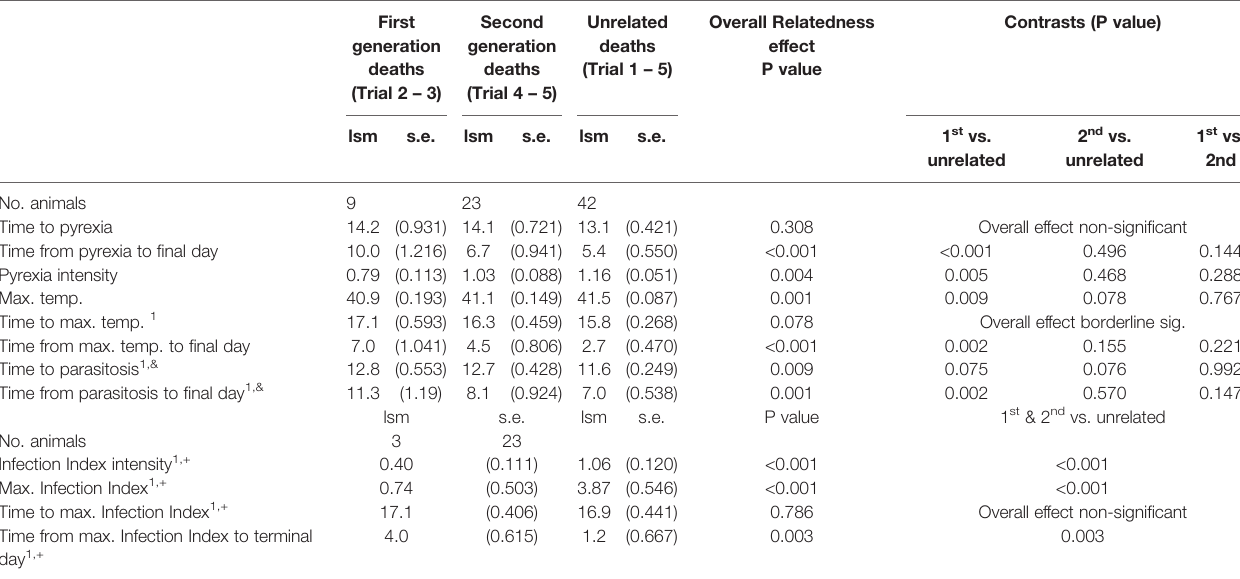
TABLE 4 | Survival, parasitosis and pyrexic data from the susceptible progeny and the susceptible unrelated